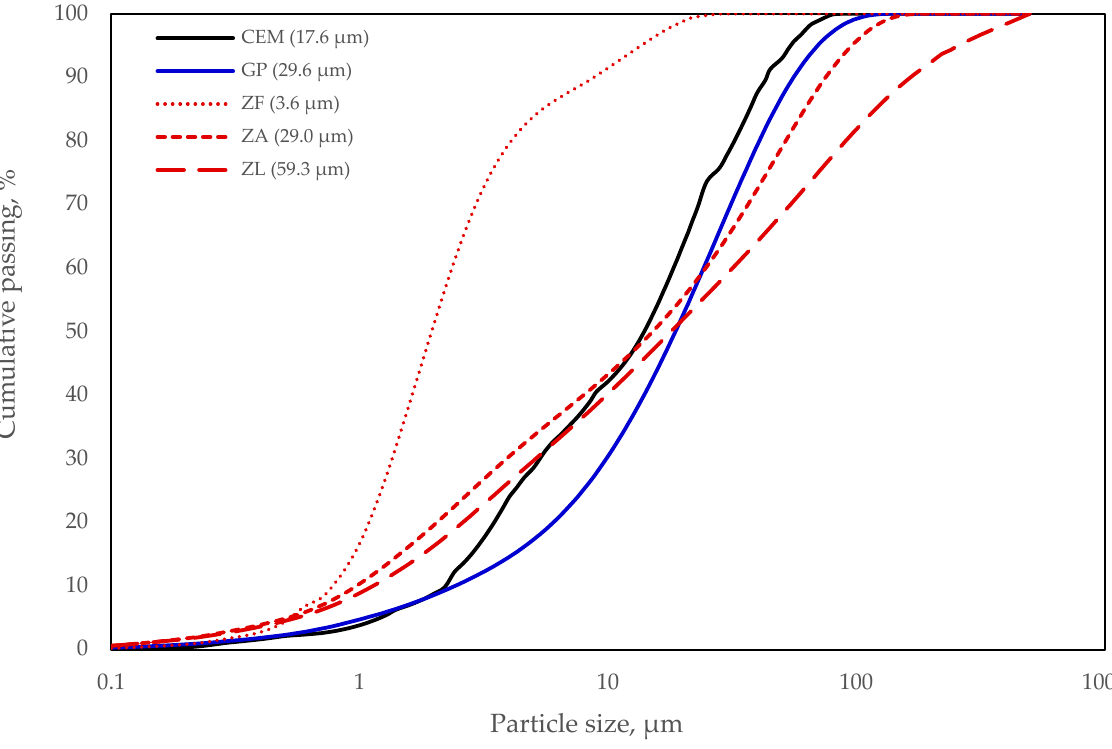
Figure 3. Cumulative passing chart of binder particle size.